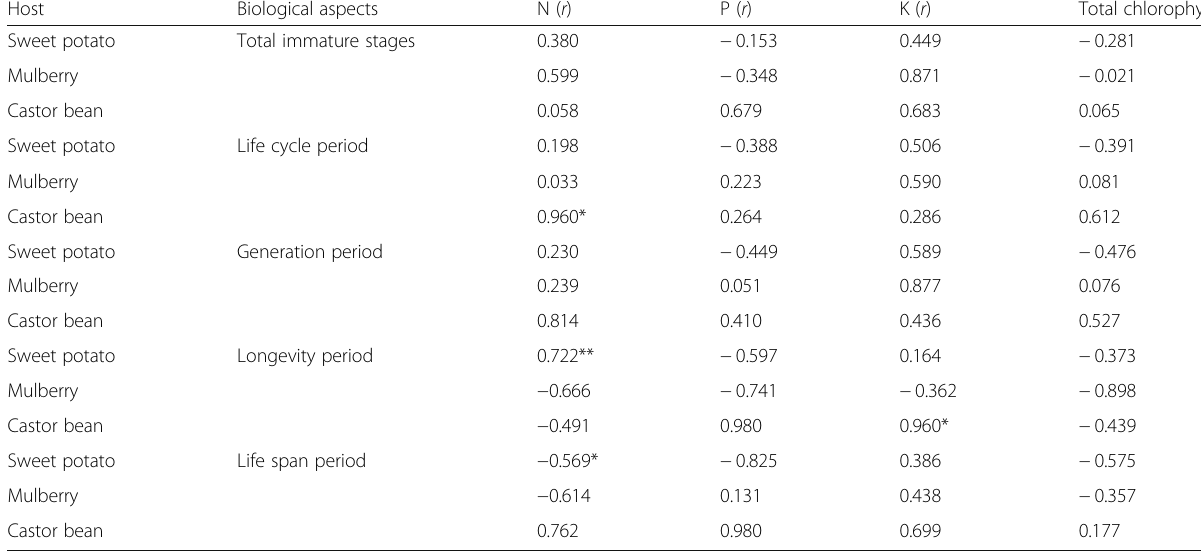
Table 3 Relationship between developmental stages of Tetranychus urticae female with nitrogen, phosphorus, potassium, and total chlorophyll in different host